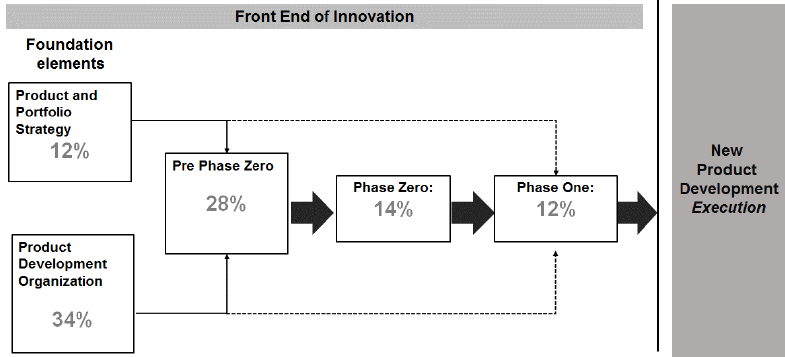
Fig. 8. Research findings through the lens of the Three Phase Front End